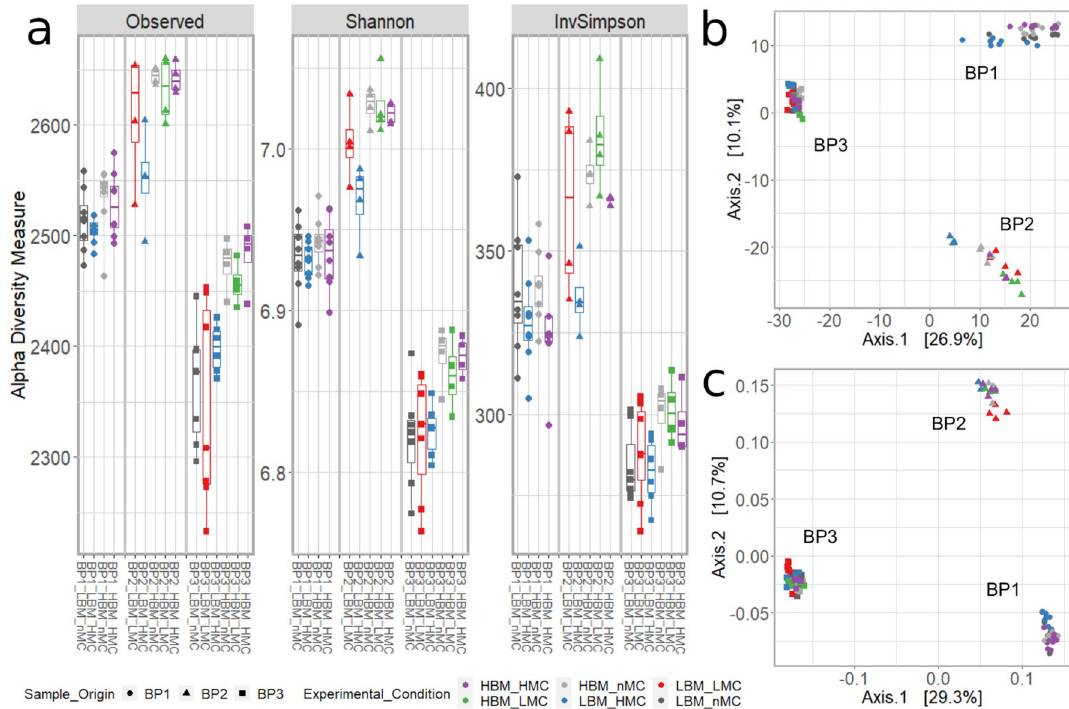
Figure 3. Diversity estimates for bovine fecal microbiota generated from sample pools BP1, BP2 and BP3 with high and low biomass and MC. ( a ) alpha diversity estimates. ( b – c ) Beta diversity estimates. PCoAs